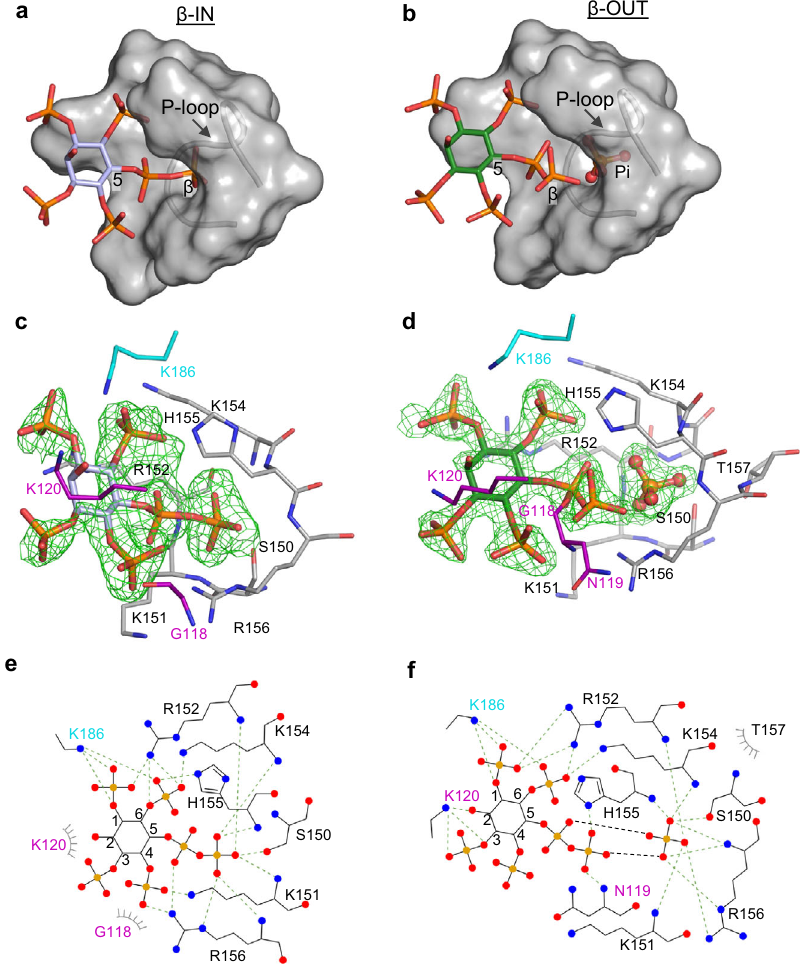
Fig. 4 At PFA-DSP1 binds 5-PP-InsP 4 in two orientations, which are associated with either the presence or absence of Pi. Panels ( a , b ) are surface representations of the ligand binding pocket, with 5-PP-InsP 4 drawn in stick format, in poses labeled β -IN (pale lavender carbons) and β -OUT (green carbons), respectively; phosphorus is orange and oxygens are red. Note the presence of Pi(B) (in stick and ball format) in panel ( b ). Panels ( c , d ) show the corresponding stick depictions of 5-PP-InsP 4 and its interacting amino-acid residues (nitrogens are colored blue). The Fo-Fc electron density maps (green mesh) are contoured at 3 σ in panel ( c ) and 5 σ in panel ( d ). Panels ( e , f ) are renderings of the corresponding ligand – protein interactions created by Ligplot + . The source data fi le is provided as PDB accession code